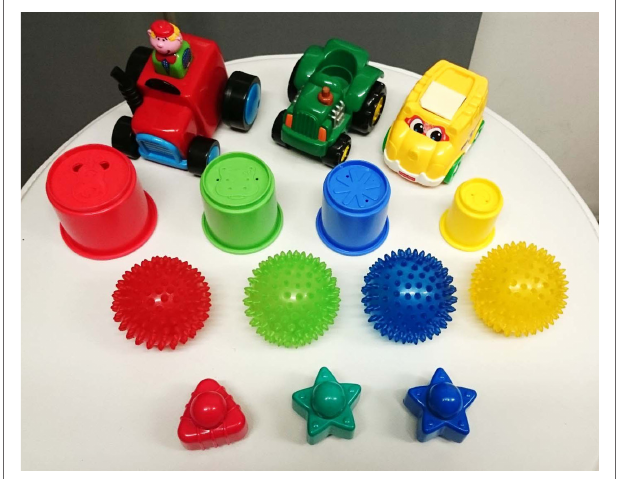
FIGURE 7 | All of the objects used in the real experiments (14 objects including four types and four